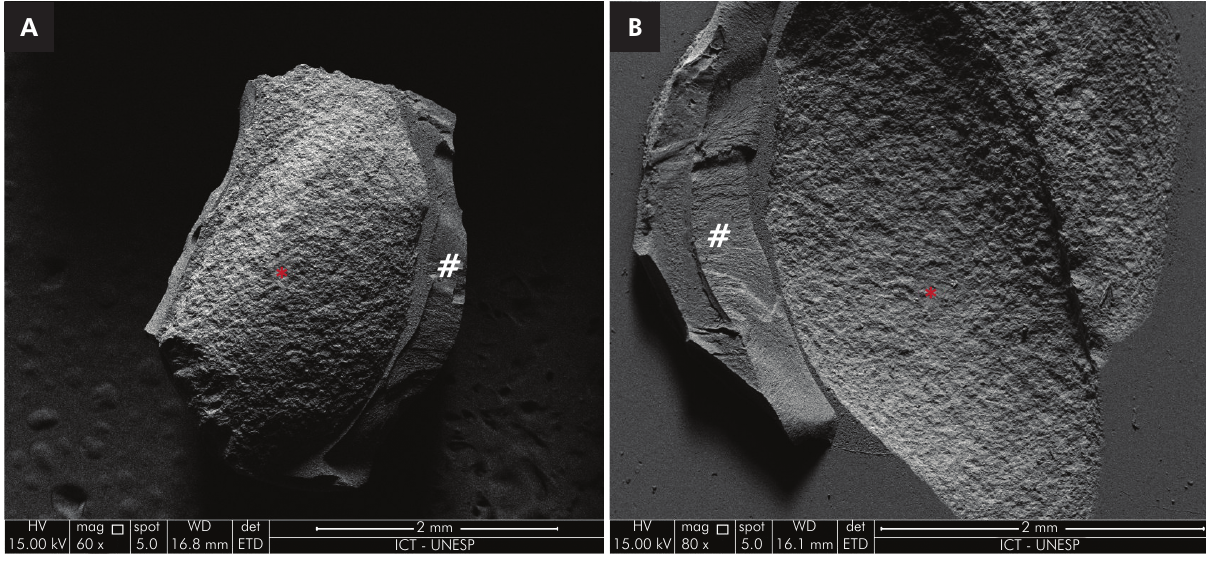
Figure 2. SEM (60x) micrographs of failure modes between the ceramic and resin cement cylinder: mixed failure (A: cohesive in cement, and B: adhesive at ceramic / cement interface). Ceramic (#), resin cement